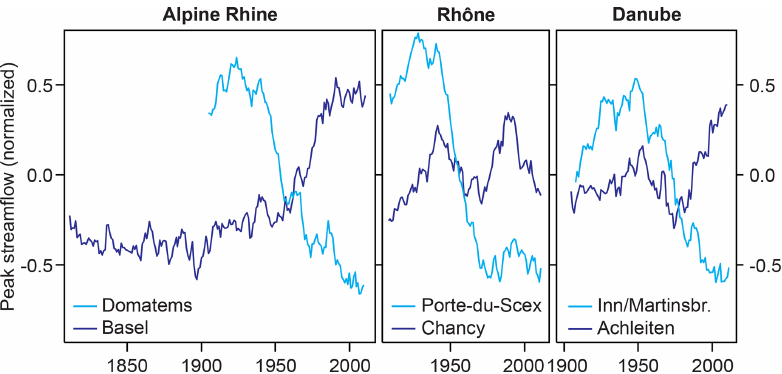
Figure 2. Normalized smoothed streamflow series for the three Alpine regions. In each region an upstream catchment (mean altitude > 2000ma.s.l., light blue) and streamflow series downstream from the same river system (dark blue) is shown. All series are smoothed with a 30-year moving